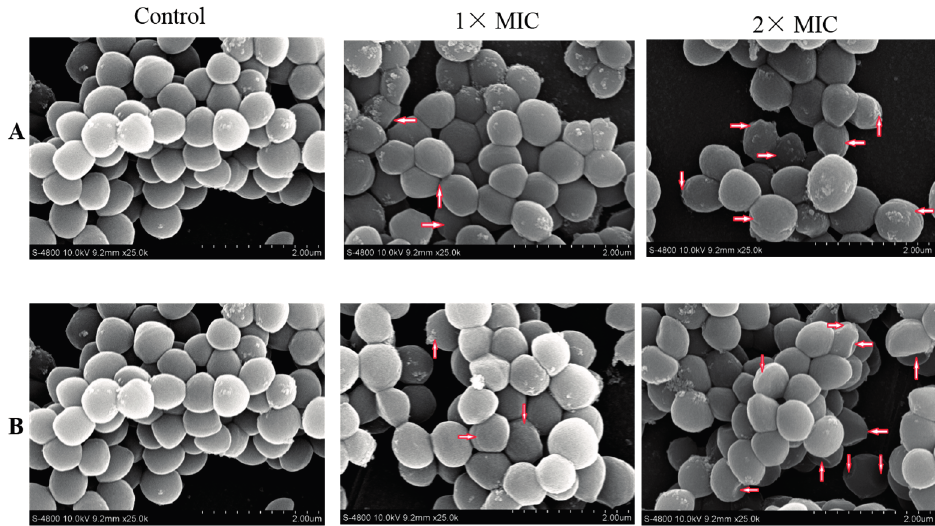
Figure 5. The Scanning Electron Microscope (SEM) photography of S. aureus . Untreated bacteria cultured for 3 h ( A , B ); bacteria treated with compound A at 1×, 2× MIC (A1, A2); bacteria treated with compound B at 1×, 2× MIC (B1, B2). The experiment were performed two times with similar results each time. The red arrows represent the observed morphological